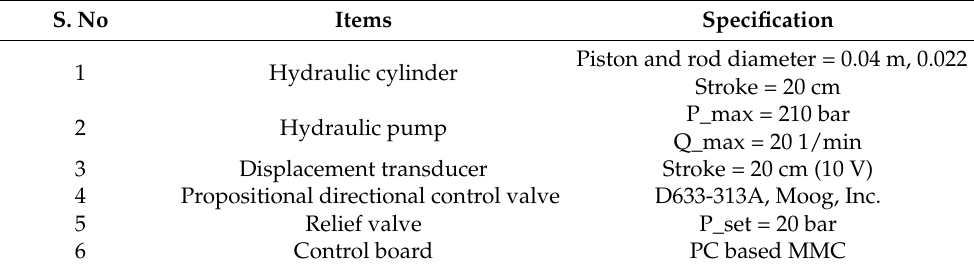
Table 1. Hydraulic servo Table 1 . Hydraulic servo system.